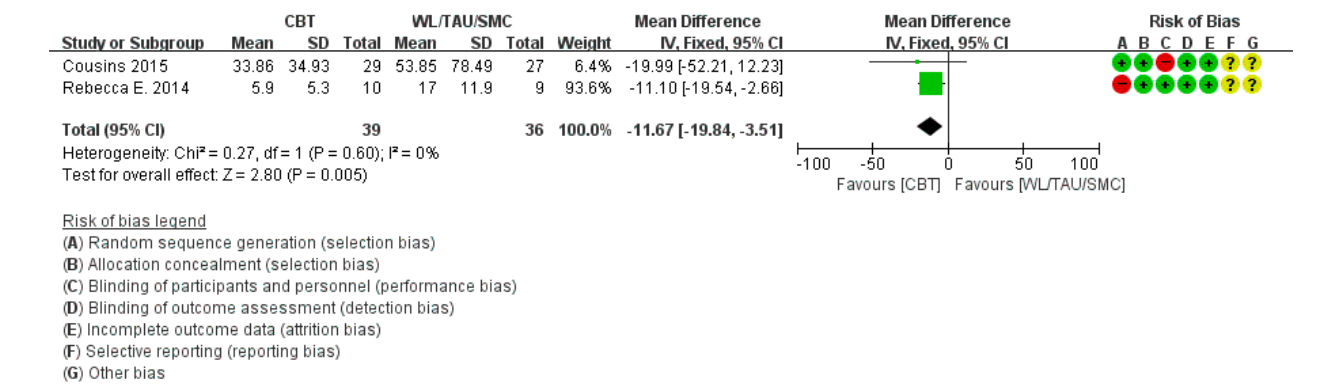
Figure 6. Subgroup analysis of cognitive behavioral treatment compared with the WL/TAU/SMC group regarding the difference from baseline in Pediatric Migraine Disability Assessment score.